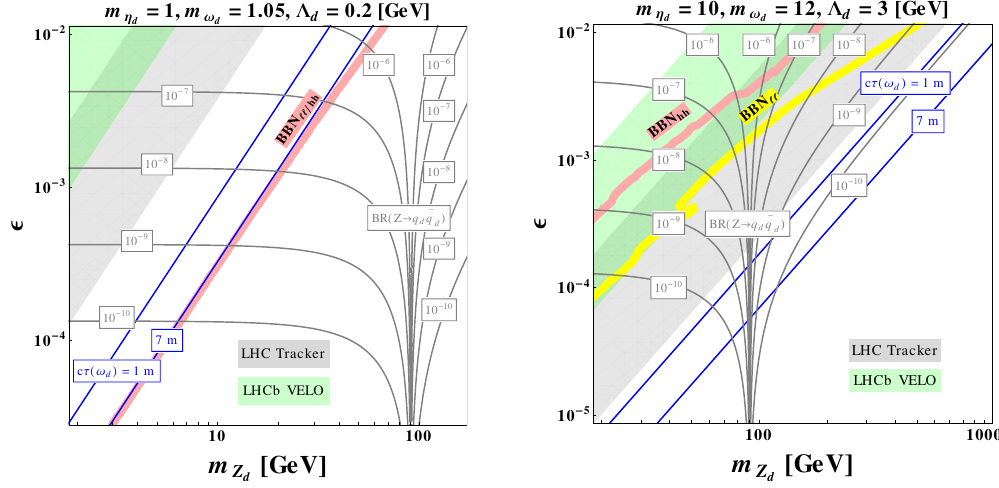
Figure 6 . Comparisons between detector size and BBN bounds on the ! d lifetime. We consider a 14 TeV search of exotic Z decay into ! d +MET, and ! d has a displaced decay into (cid:22)(cid:22) . The BBN bounds (red and yellow curves) favor the upper left region of the parameter space, which allows quick ! d decays to suppress (cid:17) d density. The green (gray) shaded region corresponds to the parameter space of having > 10% probability for ! d to decay inside the LHCb VELO (ATLAS/CMS inner detector), with the approximated detector geometries assumed in the beginning of section 4. The decay probability takes into account the boost factor and angular distribution of ! d obtained from MadGraph5 simulations. Two blue curves c(cid:28) ( ! d ) = 1 and 7 m roughly correspond to the distance from the primary vertex to the ECAL and muon chamber in ATLAS/CMS. We show contours of BR( Z q d (cid:22) q d ) assuming dark photon coupling (cid:11) d = (cid:11) !